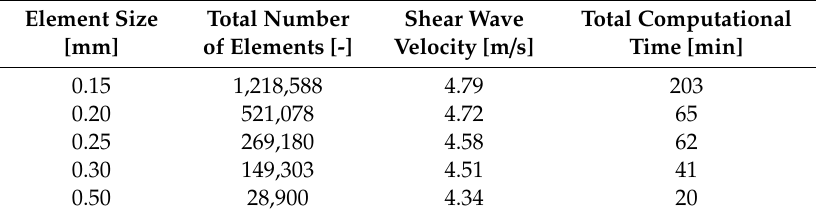
Table 2. Averaged shear wave velocity values of backward and forward propagating waves together with their computational times are shown for the considered meshes (computational specification mentioned in Section 3.1.2). The analytical value of the shear wave velocity is 4.82 m / s.